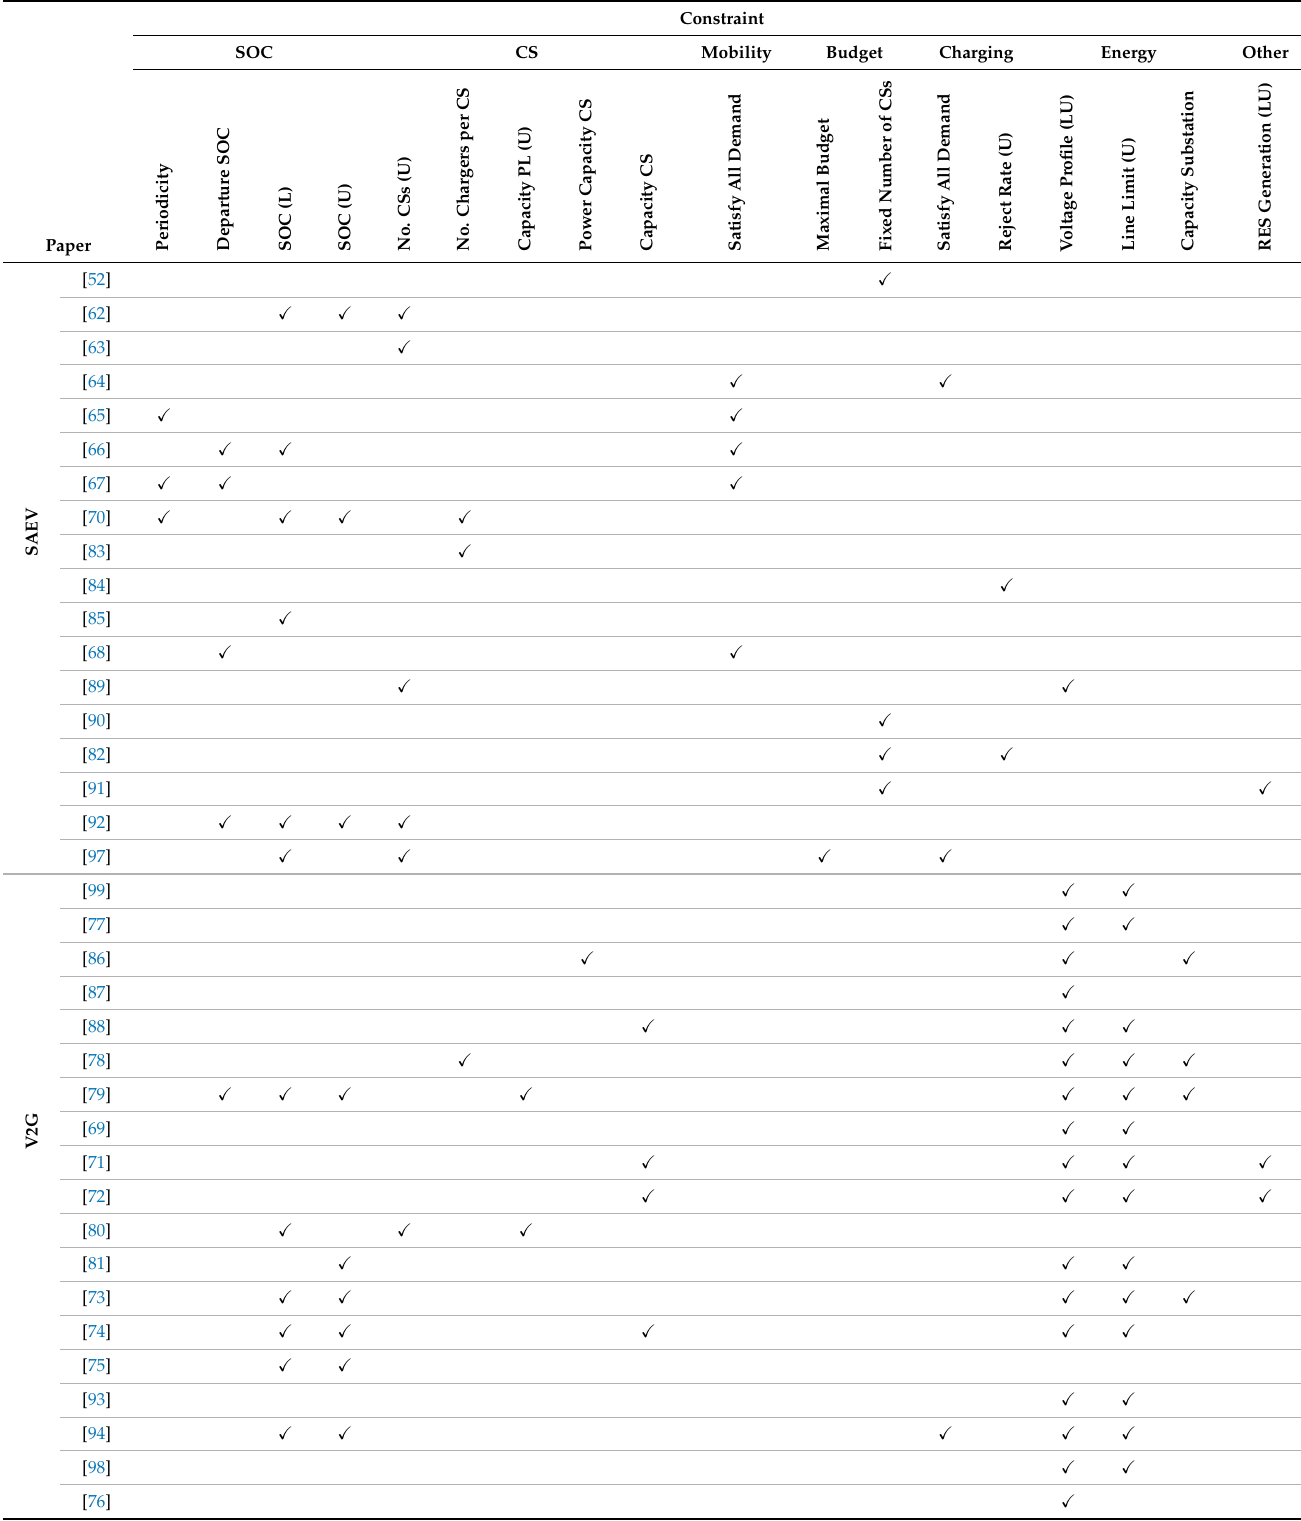
Table A3. The different constraints considered by SAEV and V2G papers. L = lower limit; U = upper limit. Constraint SOC CS Mobility Budget Charging Energy